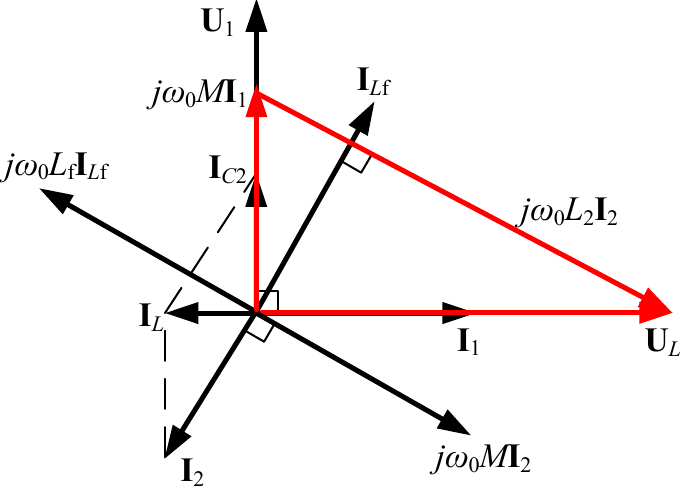
Figure 2. Phasor diagram of a WPT system with the LCC-P topology.